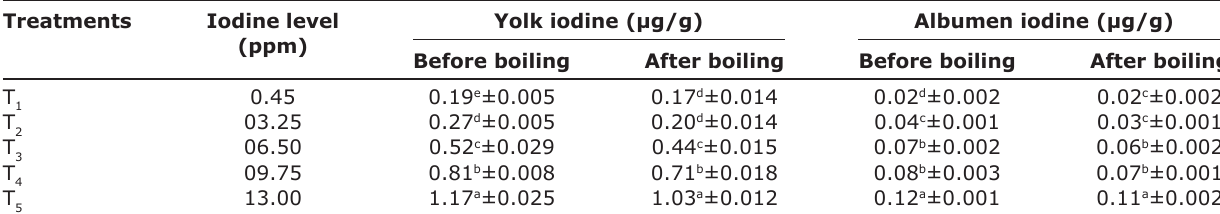
Table-2: Concentration of iodine in eggs of laying hens fed on various levels of iodine after 5 th week of supplementation (before and after boiling). Treatments